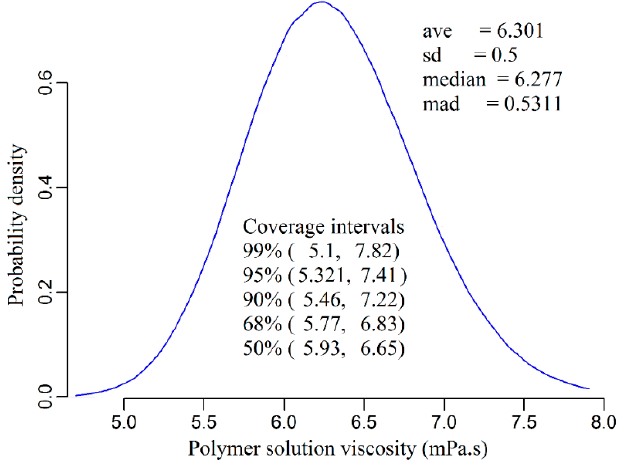
Figure 5. Probability density of the viscosity model output quantity.